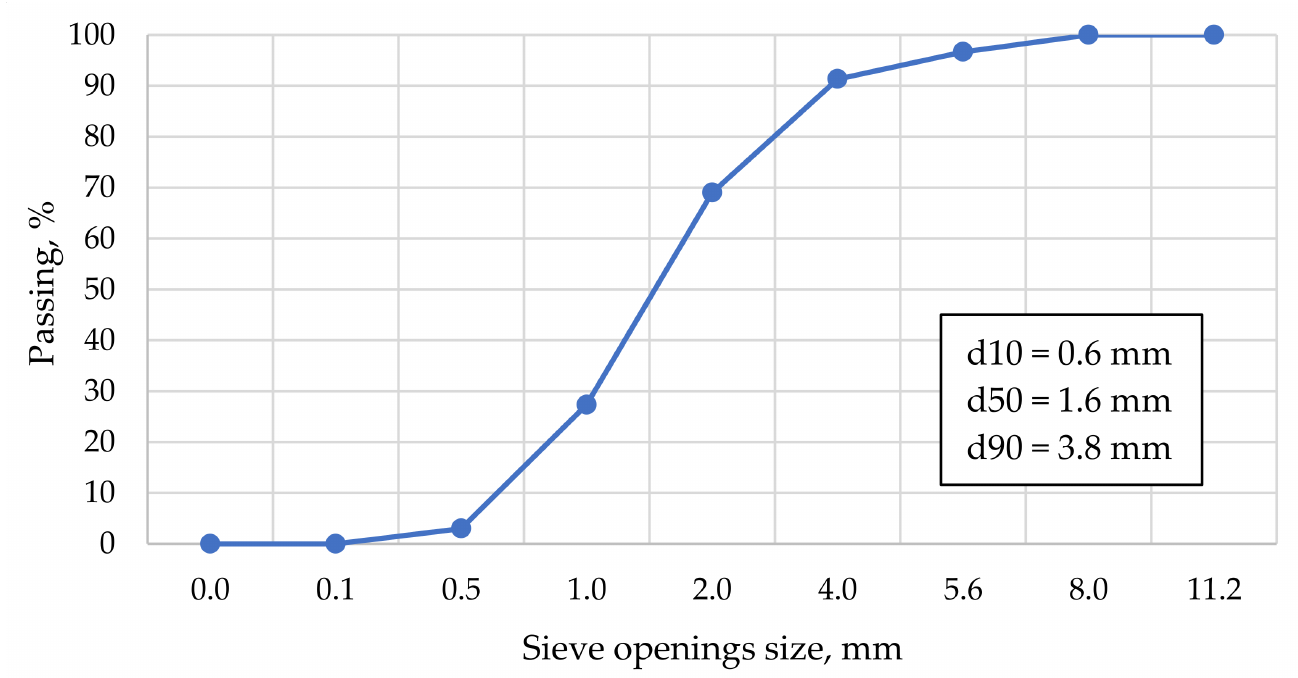
Figure 1. Shive granulometric